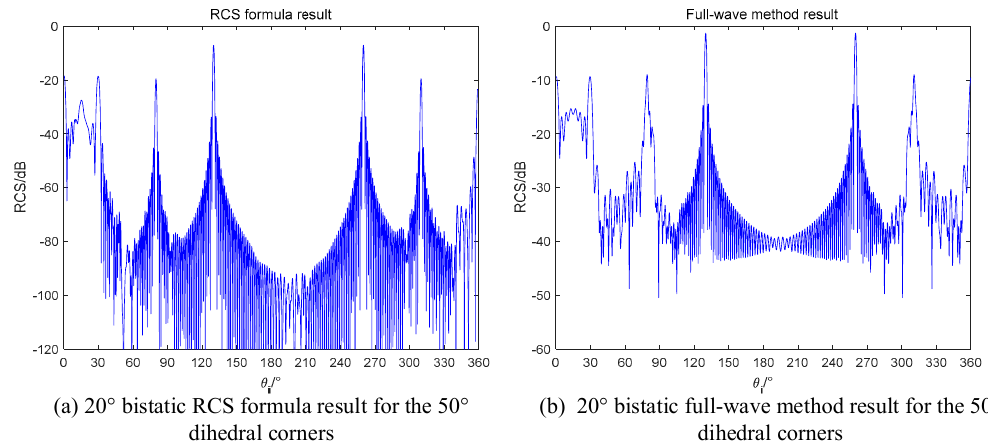
Figure 17. Monostatic RCS of the 50° dihedral ( a ) RCS formula in this paper; ( b ) Full-wave method.